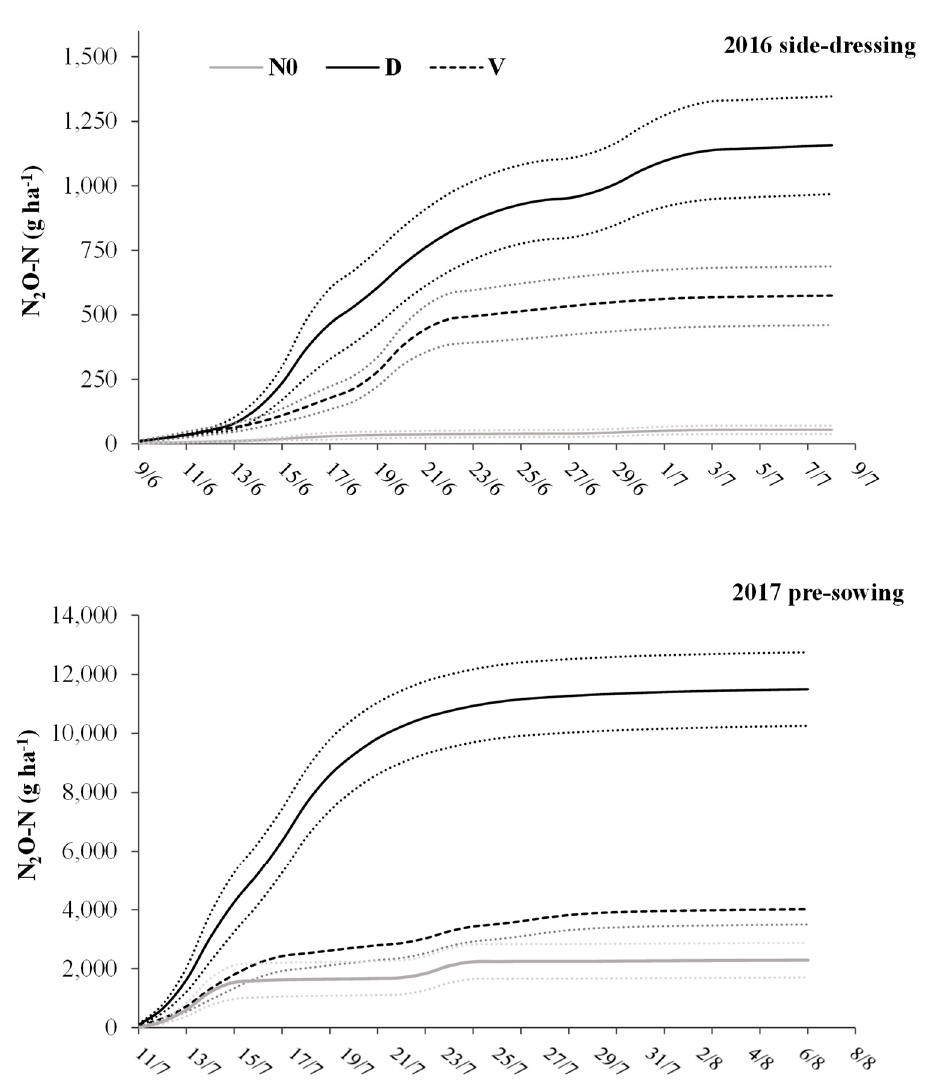
Figure 3. Cumulative N 2 O emissions (g N 2 O-N ha − 1 ) after side-dressing (“2016”, upper panel) and pre-sowing (“2017”, lower panel). Non-fertilized plot (N0), digestate injection (D) and digestate + DMPP injection (V). Dotted lines represent the standard deviation of the cumulated emissions measured in the three blocks.